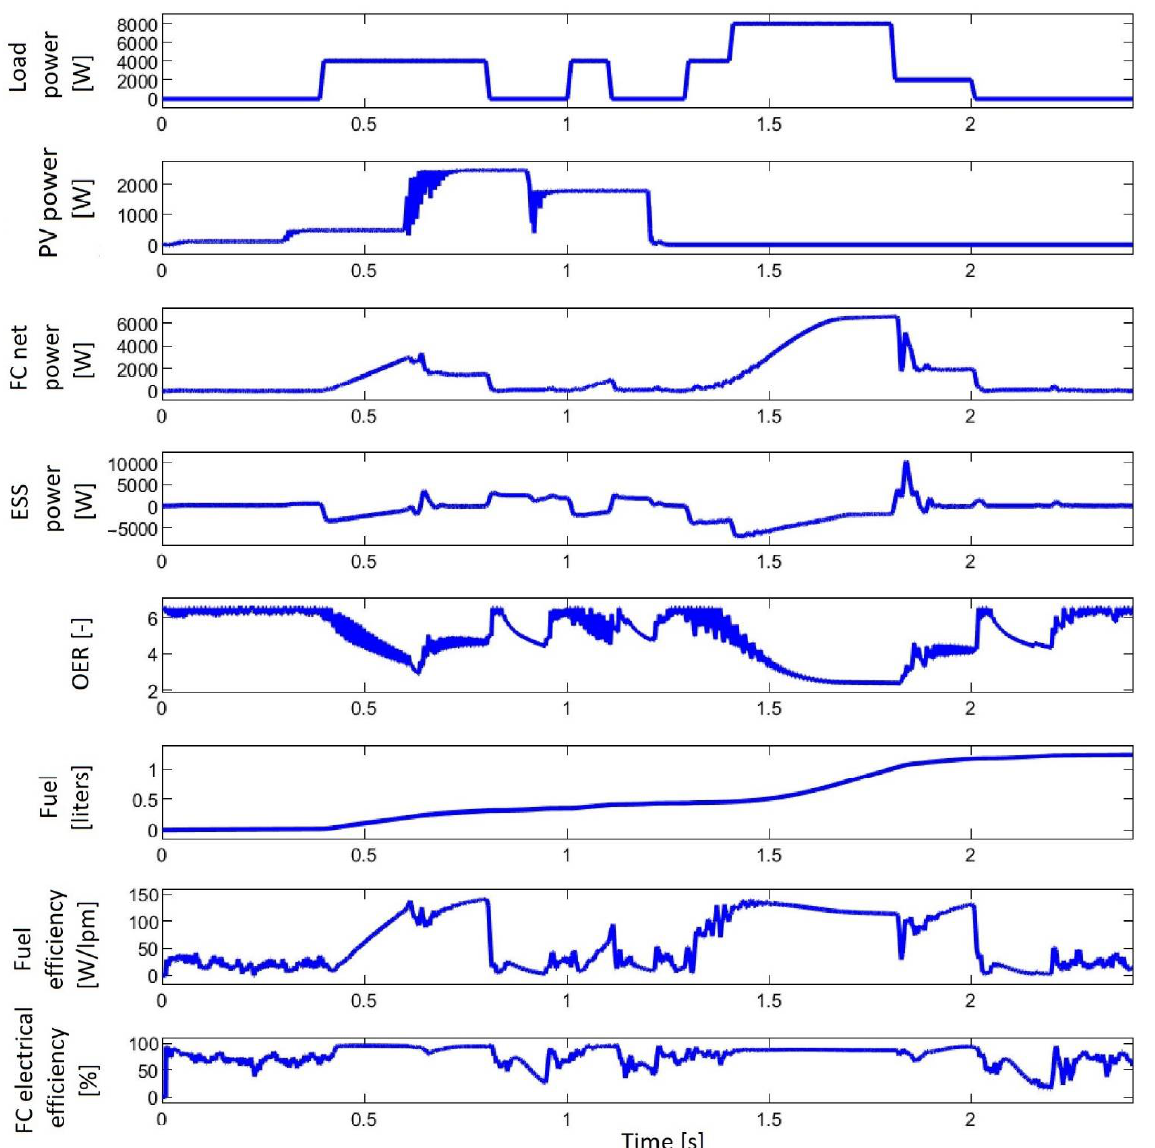
Figure 13. The behavior of the PV/FC/ESS system using strategy S1 in the scenario SC5.